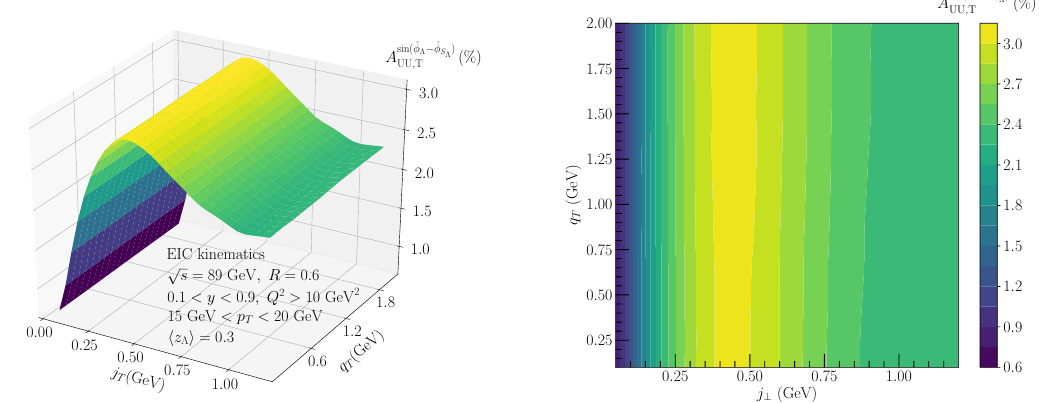
sin(ˆ φ ˆ φ S Λ ) Λ − Figure 9 . A as a function of jet imbalance q T and j ⊥ for transversely polarized Λ in jet UU,T production with electron in unpolarized ep collision with EIC kinematics, where we have applied √ s = 89 GeV, jet radius R = 0 . 6 , inelasticity y in range [0 . 1 , 0 . 9] , Q 2 > 10 GeV 2 , jet transverse momentum p T in range [15 , 20] GeV and average momentum fraction h z Λ i = 0 . 3 . Left: three- dimensional plot of the spin asymmetry in q T and j ⊥ . Right: contour plot of the same quantity.